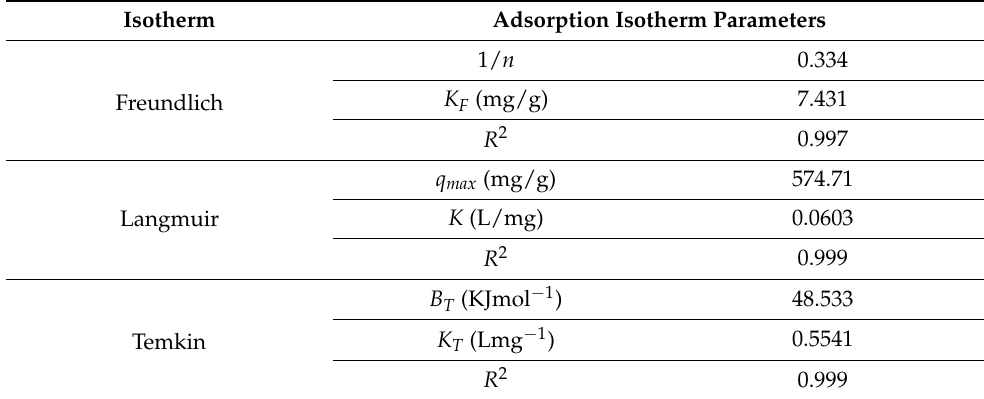
Table 2. Adsorption isotherms parameters for Pb(II) adsorption on chemically modified